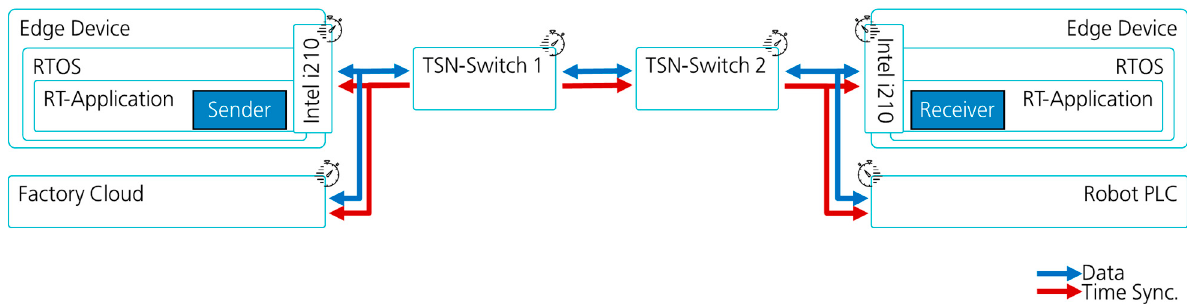
Figure 2. Architecture of the TSN setup with connection points for the PLC and the factory cloud. Setup of the TSN Switches